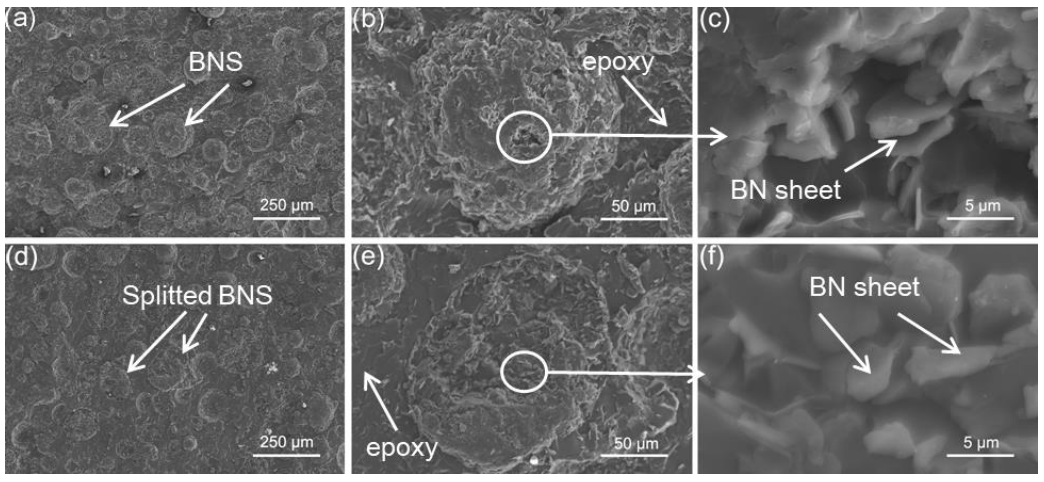
Figure 3. The representative SEM image of the BNS sphere and inside BN sheets loaded in epoxy.